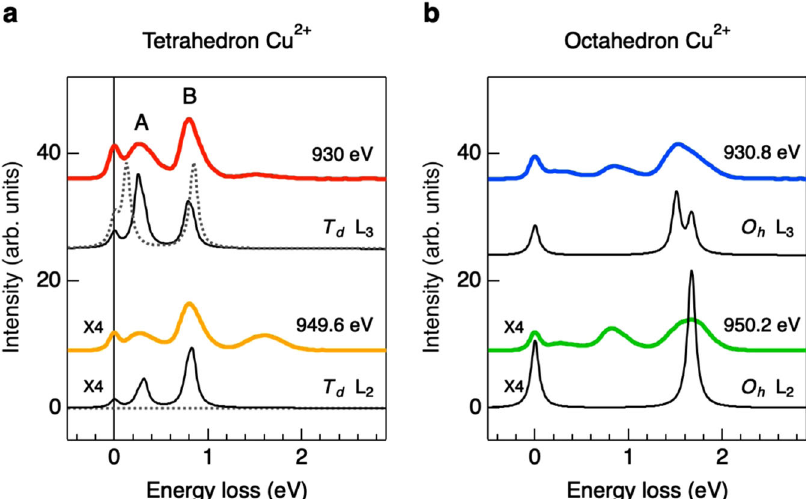
Fig. 3 Cu L -edge RIXS spectra recorded at selected incident photon energies in comparison with multiplet calculations. a RIXS spectra measured with the incident photon energies tuned to the resonance of T d Cu 2 + compared with calculated RIXS. The solid black lines plot the calculated spectra of T d Cu 2 + with the Jahn-Teller distortion; the dashed gray lines are for those in a spin-orbital entangled state. The calculated RIXS intensity of T d Cu 2 + in the J eff = 1/2 state vanishes. See the main text for the discussion on the origin of peaks A and B. b Measured RIXS of O h Cu 2 + in comparision with calculations. The solid black lines plot the calculated spectra of O h Cu 2 + without a distortion. The incident photon energies E in indicated in ( a ) and ( b ) correspond to the red dashed lines shown in Fig. 2. Both experimental and calculated RIXS spectra of Cu L 2 edge are magni fi ed by a factor of four.